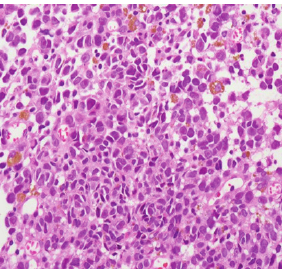
Figure 3: Histologically the tumor mainly consisted of poorly cohesive neoplastic cells with hyperchromic muclei and cytosolic melanin granules which predominantly proliferated in the mucosa (Hematoxylin and eosin stain, × 400).